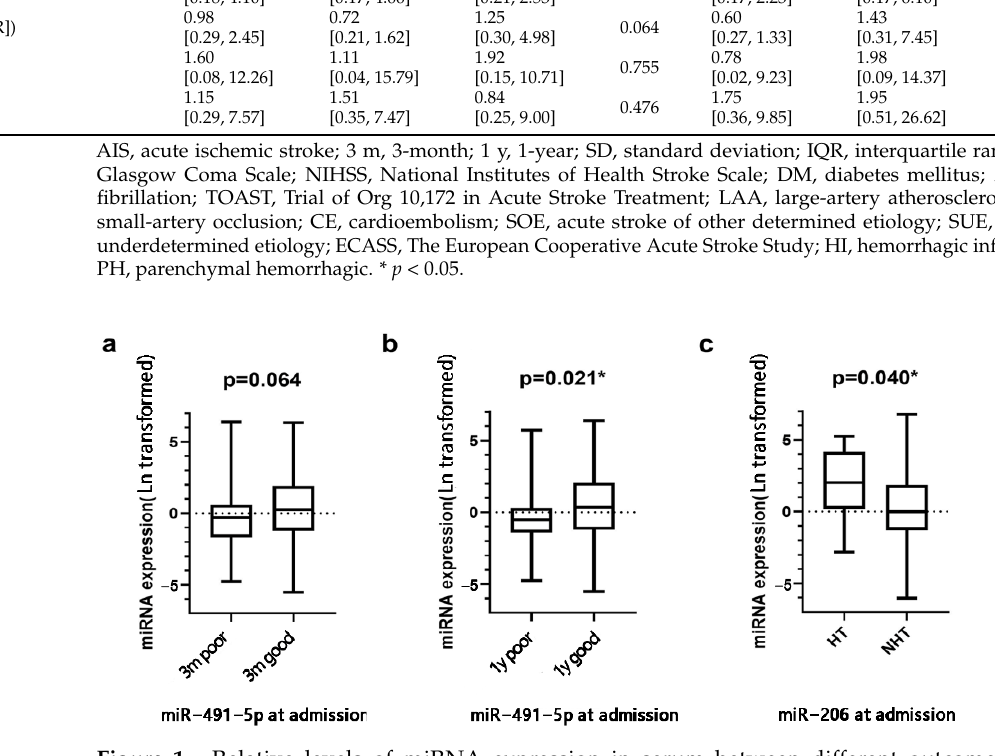
Figure 1. Relative levels of miRNA expression in serum between different outcome groups. ( a ) A non − significant trend of lower miR − 491 − 5p level was observed in patients with 3 − month poor outcome. ( b ) Significantly lower miR-491-5p level was observed in patients with 1 − year poor outcome. ( c ) Patients with spontaneous HT had higher level of miR − 206. The expression levels of miRNAs were performed with the natural log(Ln)-transformed data. The Mann − Whitney U test was used for statistical analysis. 3 m, 3 − month; 1 y, 1 − year; HT, hemorrhagic transformation; NHT, non − hemorrhagic transformation * p < 0.05.